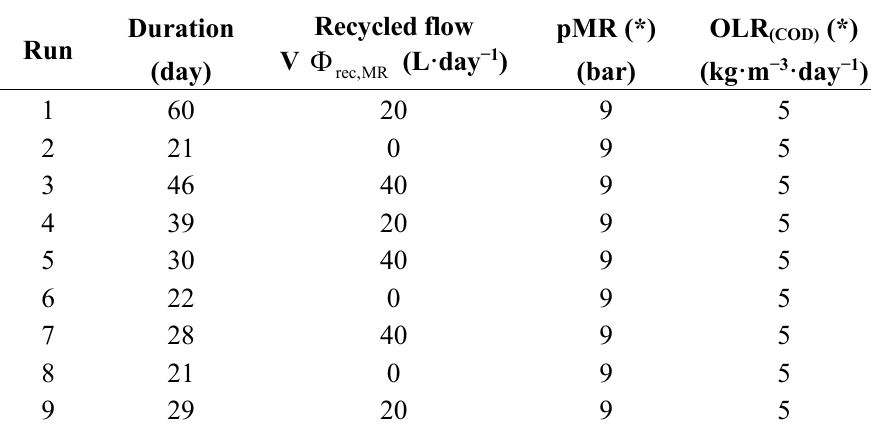
Table 1. Experimental